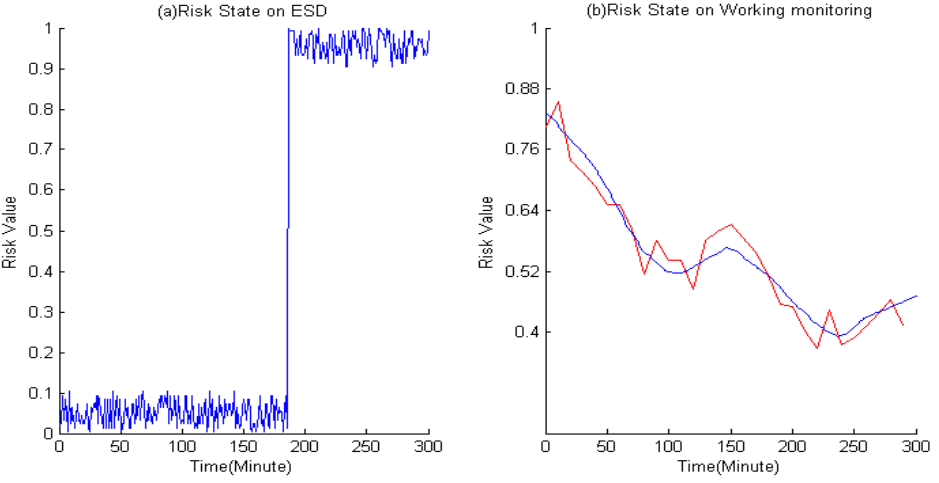
Figure 6. Status with time on emergency shutdown device and work monitoring system.